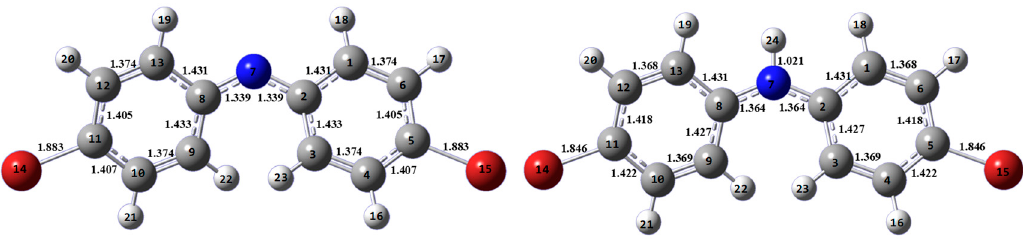
Figure 4. Optimized structures of the N,N–di(4–bromophenyl)nitrenium ion ( DN ) (left) and the dication species 4 (right).